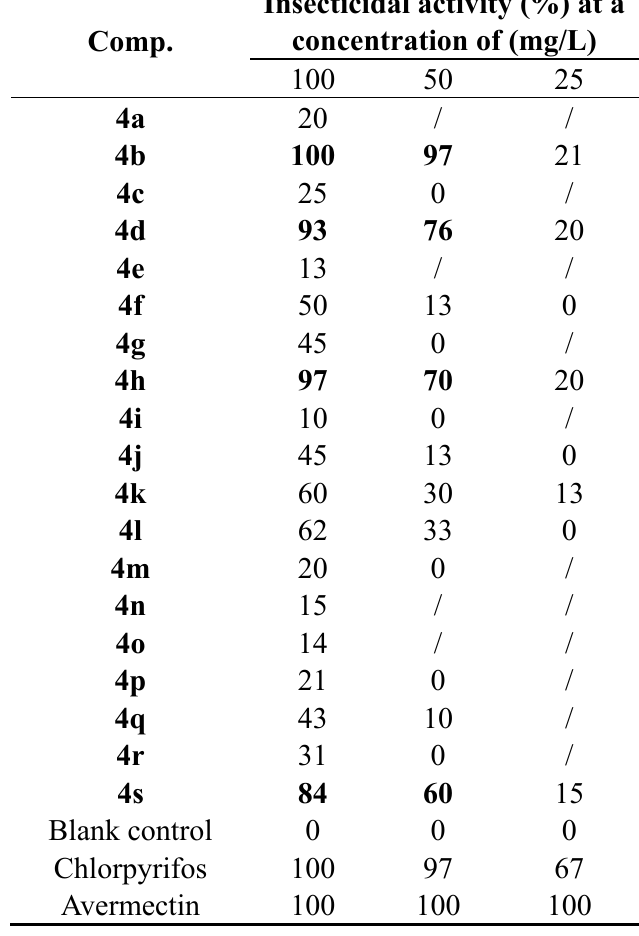
Table 1. Insecticidal activity of the synthesized compounds against P. xylostella .